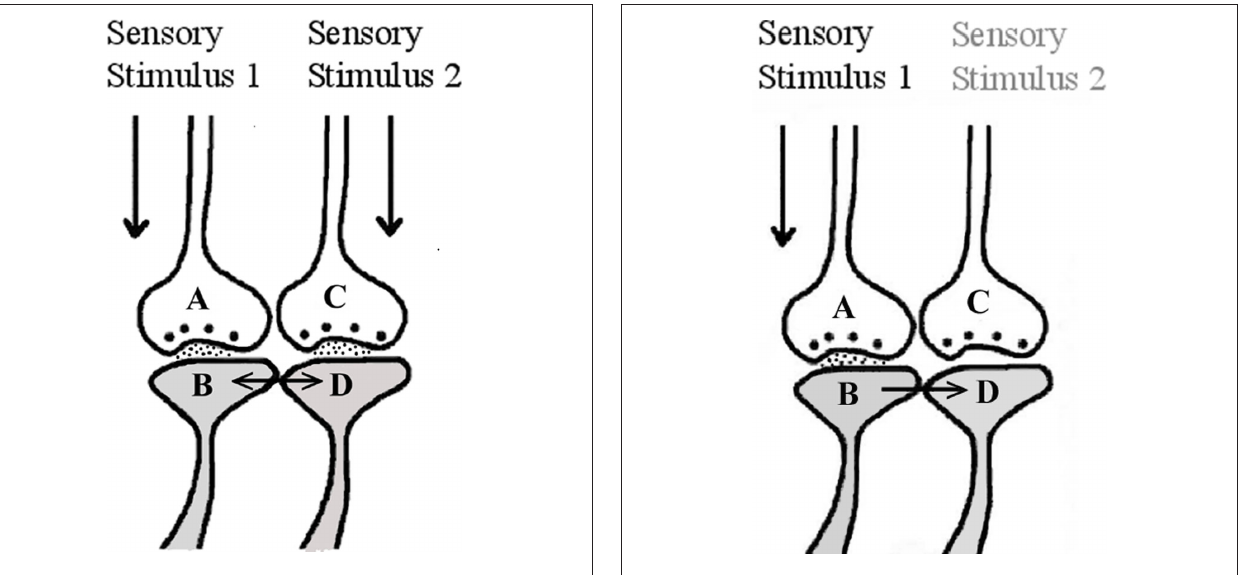
FIgure 1 | Illustration showing the formation of functional LINK between two postsynaptic membranes B and D during binding. The functional LINK is transient and is a function of the simultaneous arrival of sensory stimuli from an item at the two postsynaptic membranes during binding. This is hypothesized to occur at locations of convergence of sensory inputs. Reactivation of the functional LINK is possible during the arrival of activity at either one of the postsynapses (B or D) at a later time (This figure is used after modification [Vadakkan, 2008] with permission from iUniverse publishers, Bloomington, IN, USA).